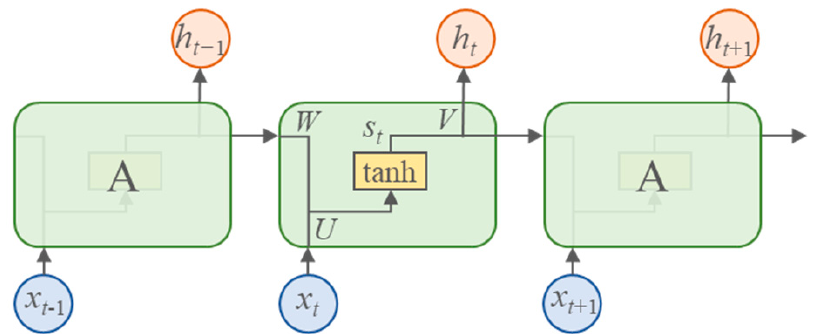
Figure 2. RNN network structure. Where remote unit;